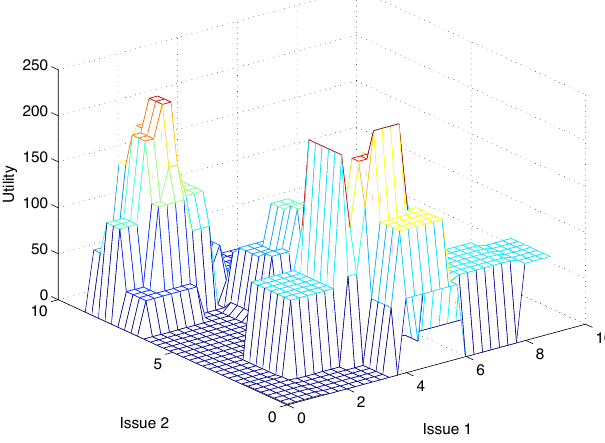
Figure 3. Utility function with multiple local